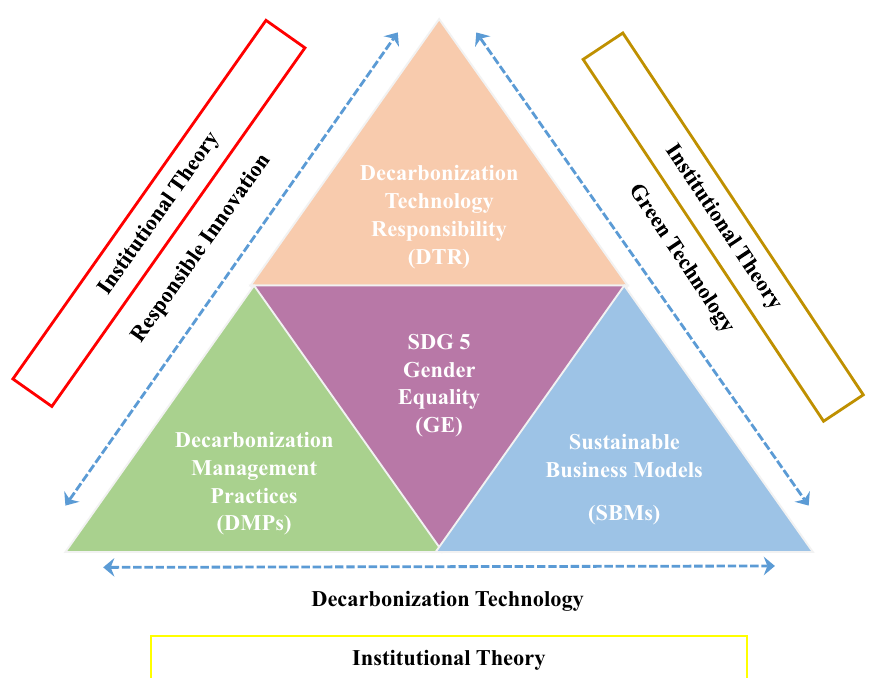
Fig. 1 Theoretical framework on DTR for gender equality through decarbonization management practices and